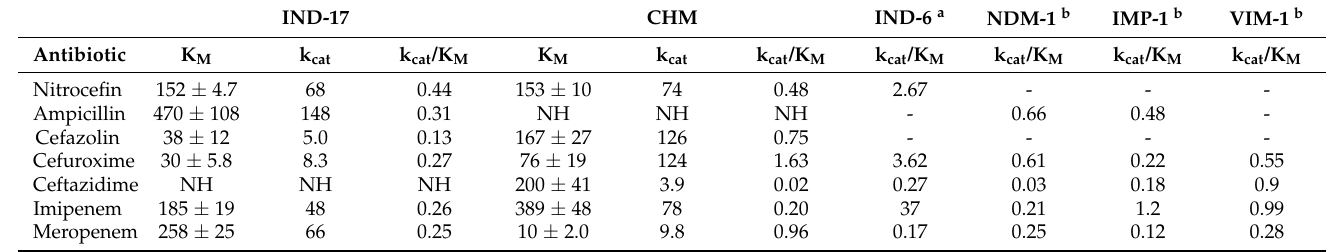
Table 4. Hydrolysis of antibiotics by IND-17 β lactamase and CHM. K M is presented in µ M, k cat